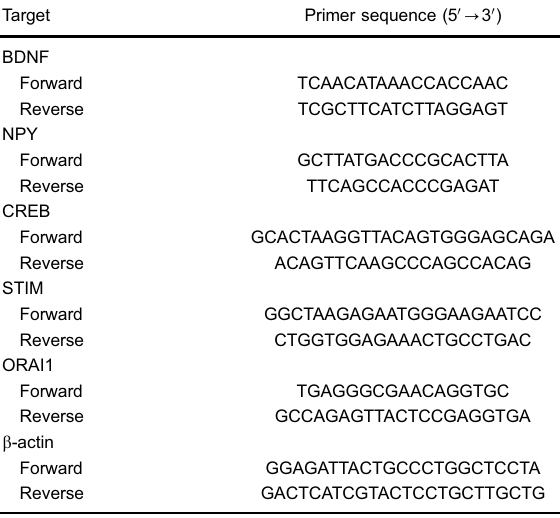
Table 1. Primer sequences for quantitative RT-PCR analysis.